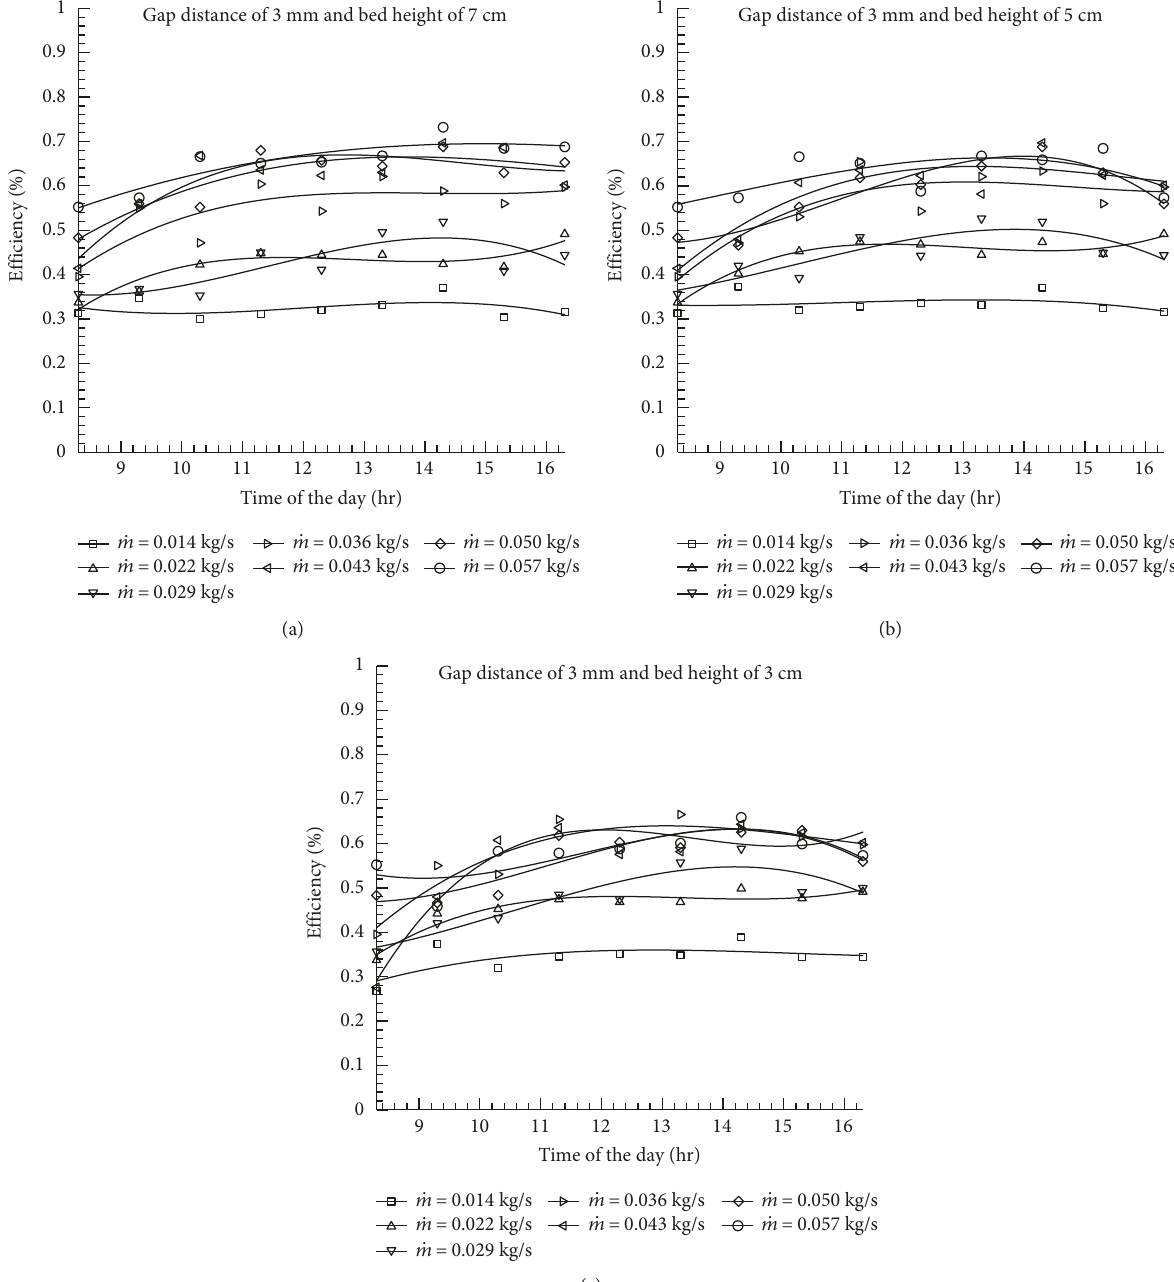
Figure 11: Thermal e ffi ciency versus time at the gap distance of 3mm for bed heights (a) 7cm, (b) 5 cm, and (c) 3cm and di ff erent mass fl ux